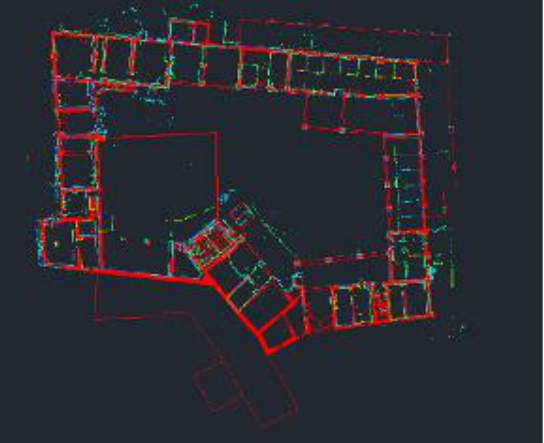
Figure 5. Example of a horizontal section.